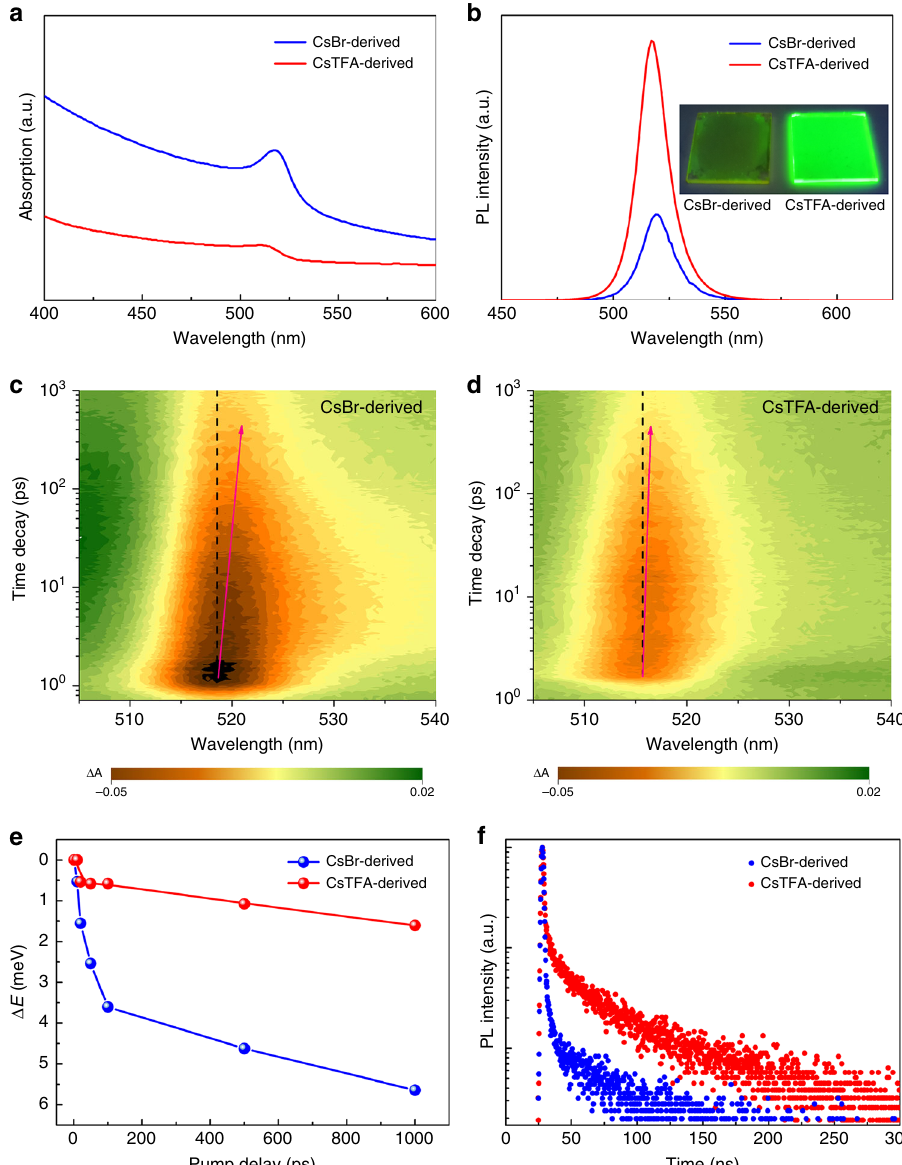
Fig. 4 Photophysical properties of the CsBr- and CsTFA-derived CsPbBr 3 perovskite fi lms. a Absorption and b PL spectra of the CsBr(1.7)- and CsTFA(1.7)- derived CsPbBr 3 perovskite fi lms. Inset in b shows the photograph of the green-emitting perovskite fi lms, taken under UV lamp excitation. c , d Transient absorption maps of the CsBr(1.7)-derived and CsTFA(1.7)-derived fi lms, respectively. Pump wavelength and pump pulse width are 365 nm and 100 fs, respectively. The red arrows indicate the trajectory of the bleach minimum position. Δ A represents optical density. e Shifts of the bleach minimum position over time for the two types of the CsBr(1.7)- and CsTFA(1.7)-derived fi lms. f Time-resolved PL decay curves of the CsBr(1.7)- and CsTFA(1.7)-derived fi lms on ITO/PEDOT:PSS